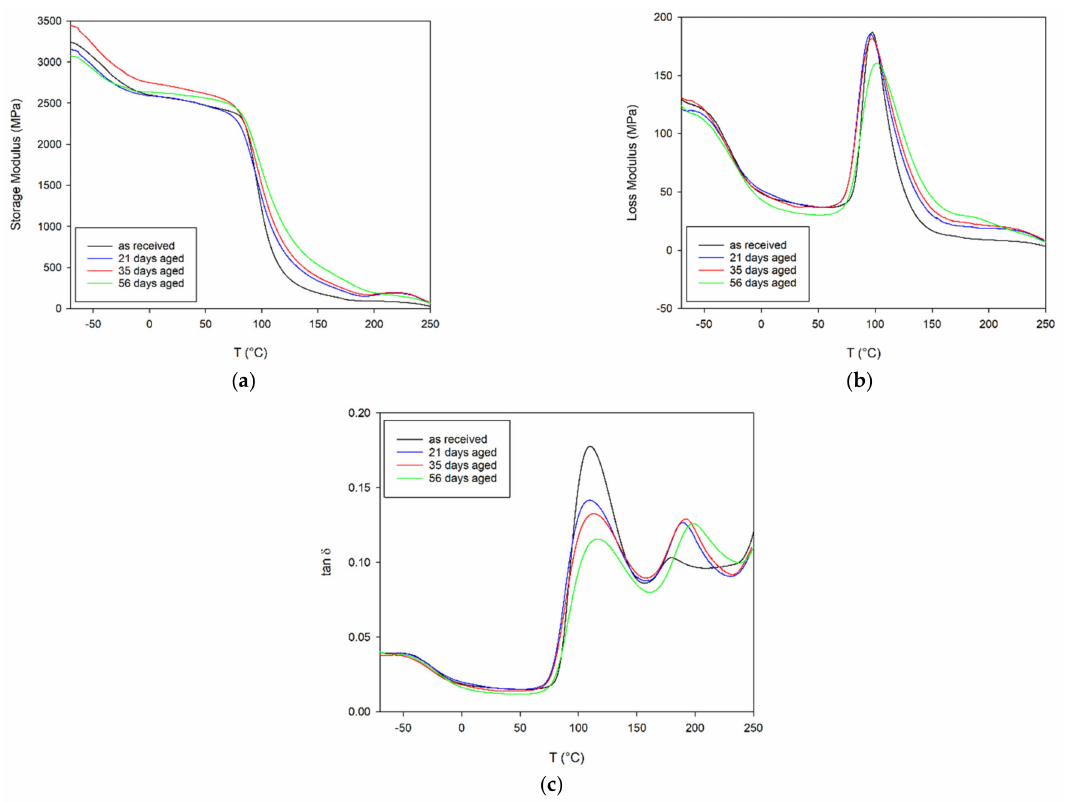
Figure 4. DMA thermogram of unaged and after ageing PET sample; ( a ) storage modulus, ( b ) loss modulus and ( c ) tan δ vs. temperature.